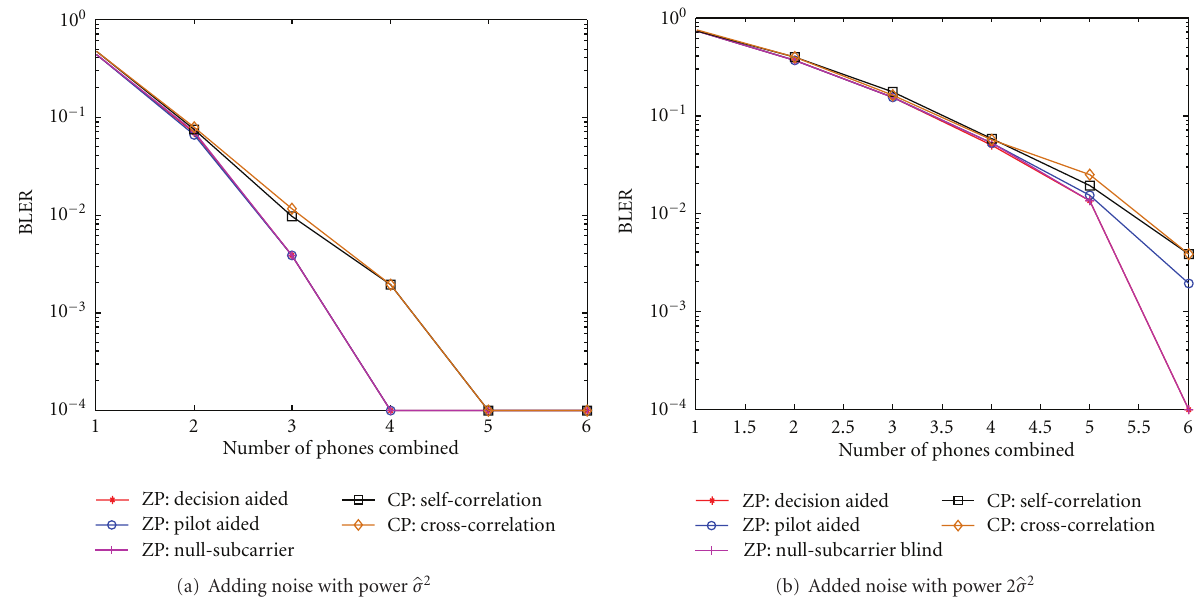
Figure 11: MACE10: BLER Performance using di ff erent Doppler estimation methods by adding artificial noise to the received signal, (cid:13) σ 2 denoting the estimated ambient noise power.